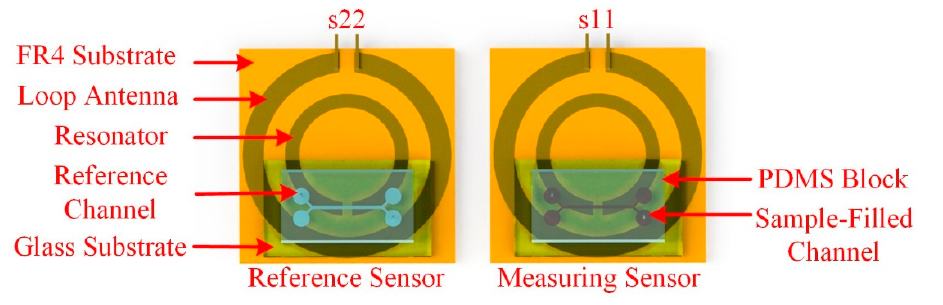
Figure 1. Sensor system used in the experiments.